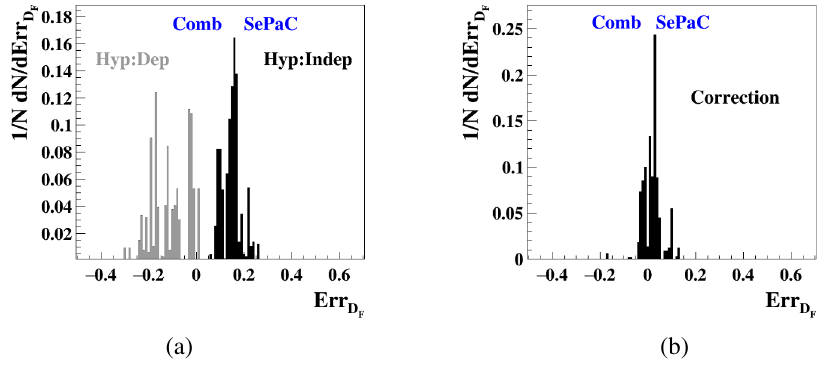
obtained using the dependent (gray area), independent F